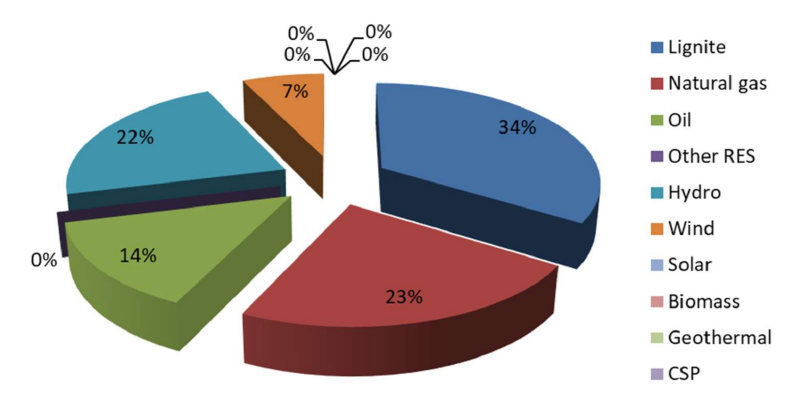
Figure 2. Percentage breakdown of installed power capacity in Greece by energy source, in 2009.